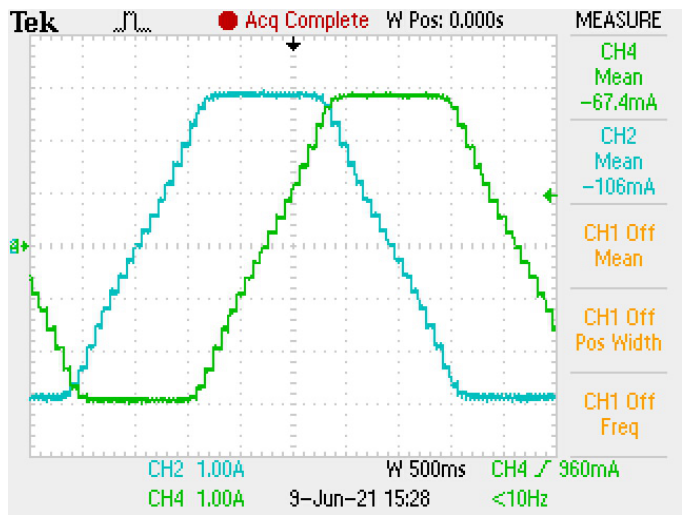
Figure 15. A–B coil currents in the p -circle control scheme for p = 8 with resolution x16.